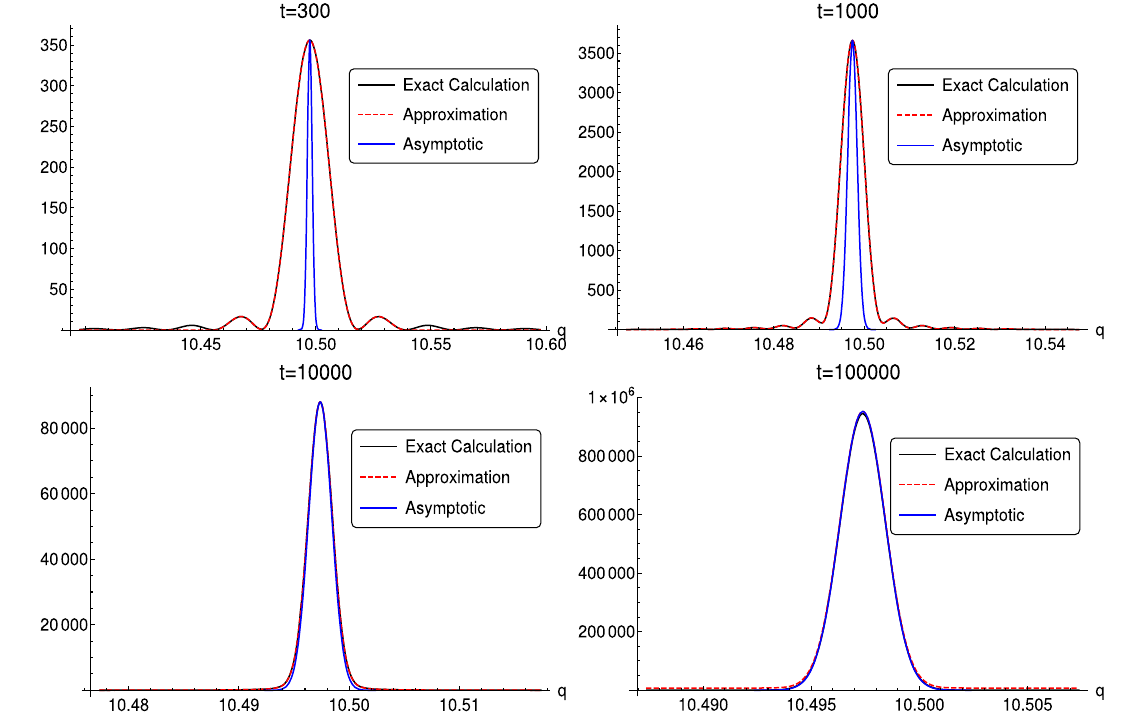
= 0 . 01. We can see that when neglected the term proportional to (cid:6) m 2 ji t (cid:9) t w (cid:3) 10 3 the dimension of the wave packet reaches the asymptotic value, given by the blue